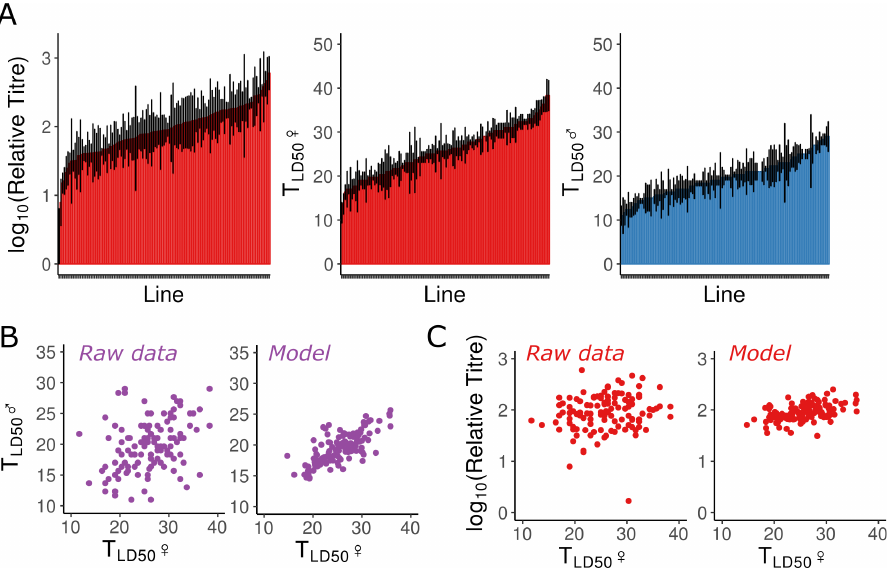
Fig 3. Genetic variation in resistance to KV. (A) We measured LT50 in both sexes, and titre in females, following KV injection in the DGRP. For titre, each bar represents the mean (and standard error) titre relative to fly genome copy- number, as assessed by qPCR for 5 vials of 10 flies for each of 125 DGRP lines. For LT50, each bar represents the mean time until half the flies (in a vial of 10) were dead, for three vials per line, per sex. (B, C) We used a multi-response linear mixed model to calculate genetic correlation between the traits. Shown are the raw data (left), and the estimated line effects (right) after accounting for any injection date and qPCR plate effects, and for the estimated variance among lines. Each point is a DGRP line measured for both phenotypes. We find a strong positive correlation between male and female LT50 values (B). We also observe a weak positive correlation between titre and LT50 (C).